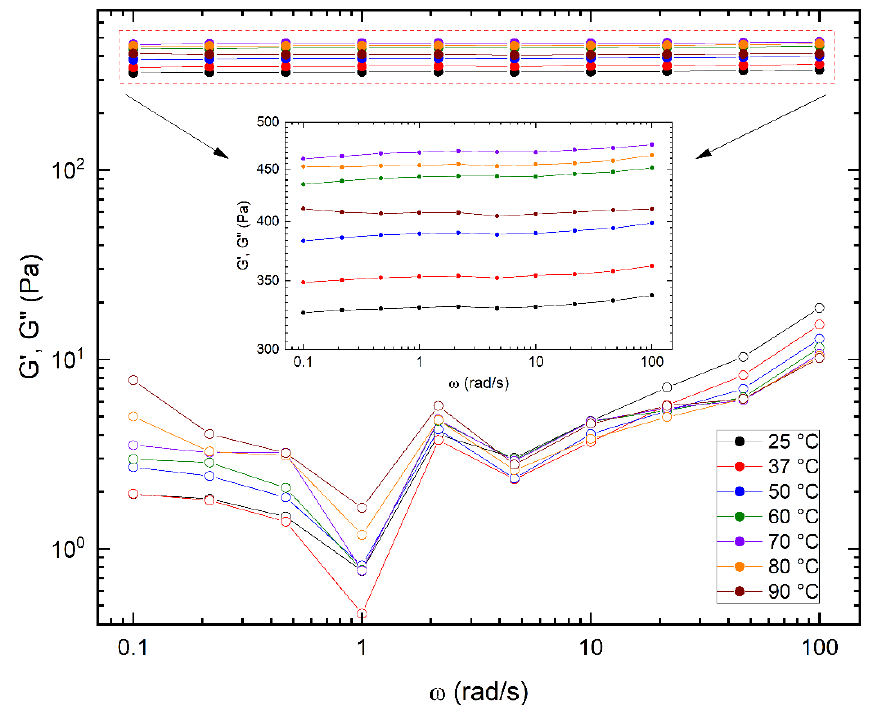
Figure 6. Mechanical spectra of N -furfuryl chitosan hydrogels based on the Diels–Alder click reaction after gelation at 70 °C. Frequency sweeps were performed at 25, 37, 50, 60, 70, 80, and 90 °C as indicated in the figure. The dependence of the storage modulus with angular frequency is magnified inside the figure. N -furfuryl chitosan 1-wt.% (21% degree of substitution) in 2% acetic acid, PEG(mal) 2 -7500, R = 0.25, and γ = 2.5 %. G ’, closed symbols, and G ’’, open symbols.